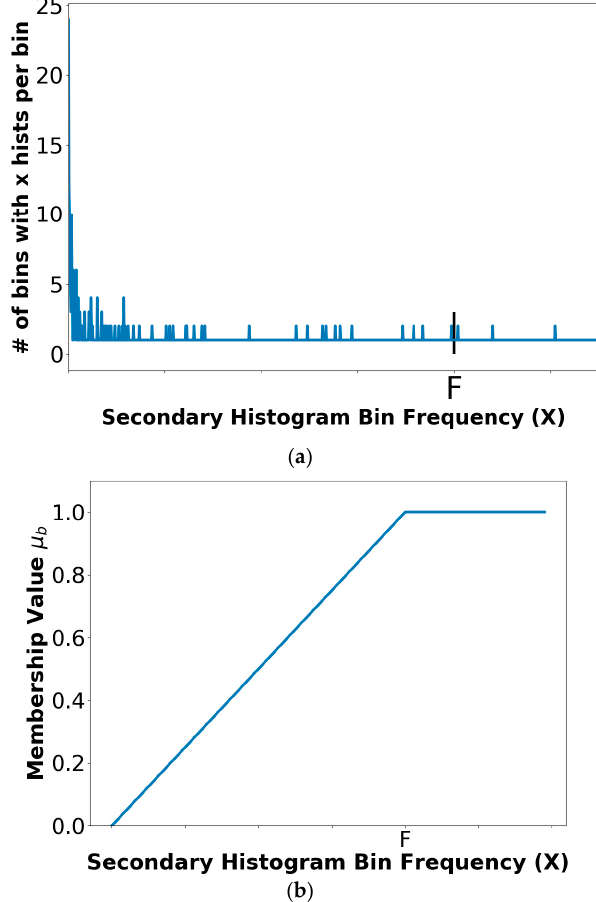
Figure 2. A relative secondary histogram ( a ) and its corresponding trapezoidal membership function for fuzzy set B ( b ). The frequency count F is labeled on the secondary histogram and membership function plot.